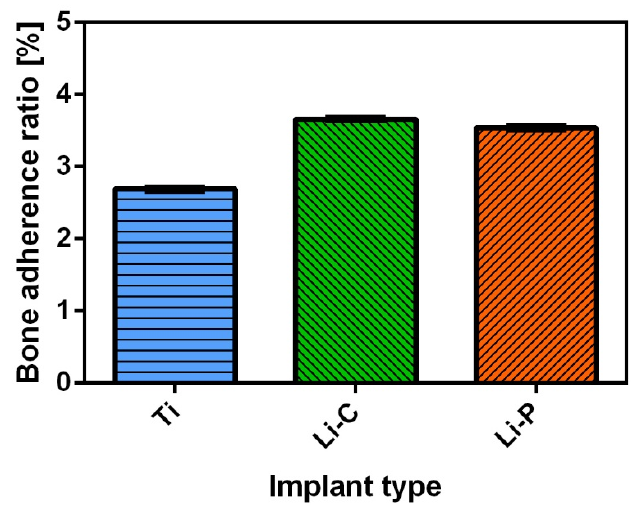
Figure 10. Inferred bone adherence ratio in the case of control and functionalized (with Li-C and Li-P coatings) 3D Ti implants ( n = 3), at 4 weeks after surgery.